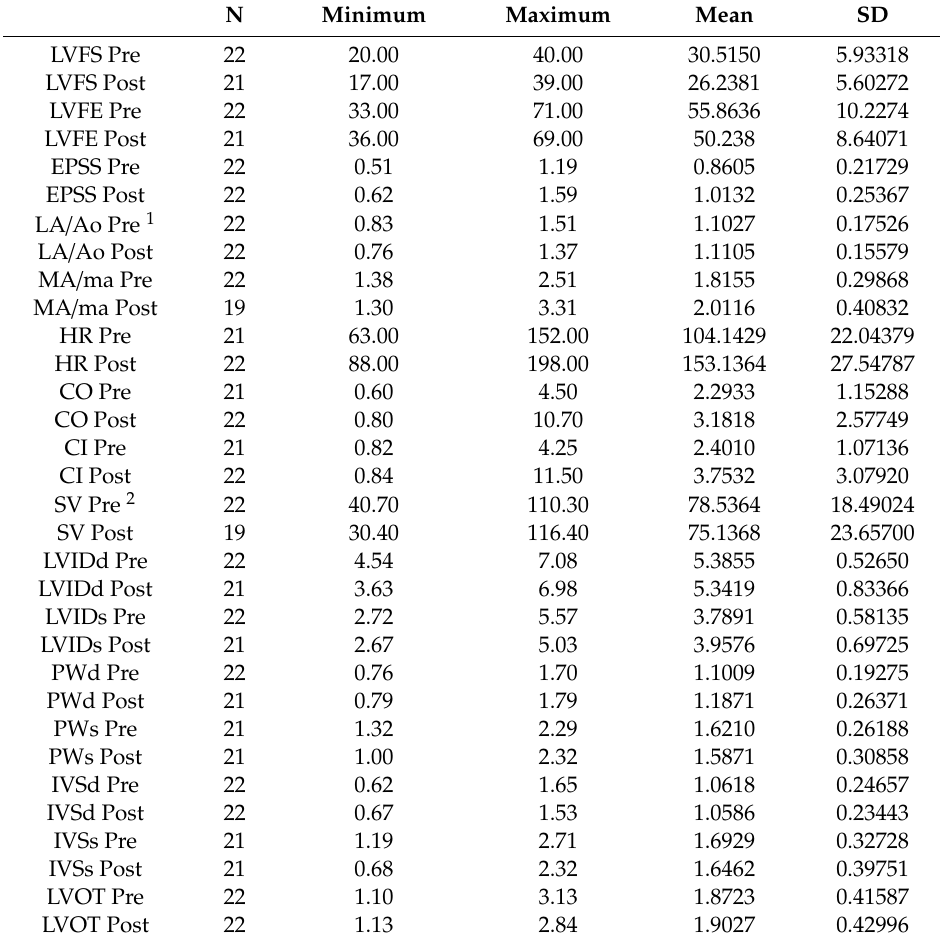
Table 7. Descriptive statistics for the pre- and post-exercise echocardiographic